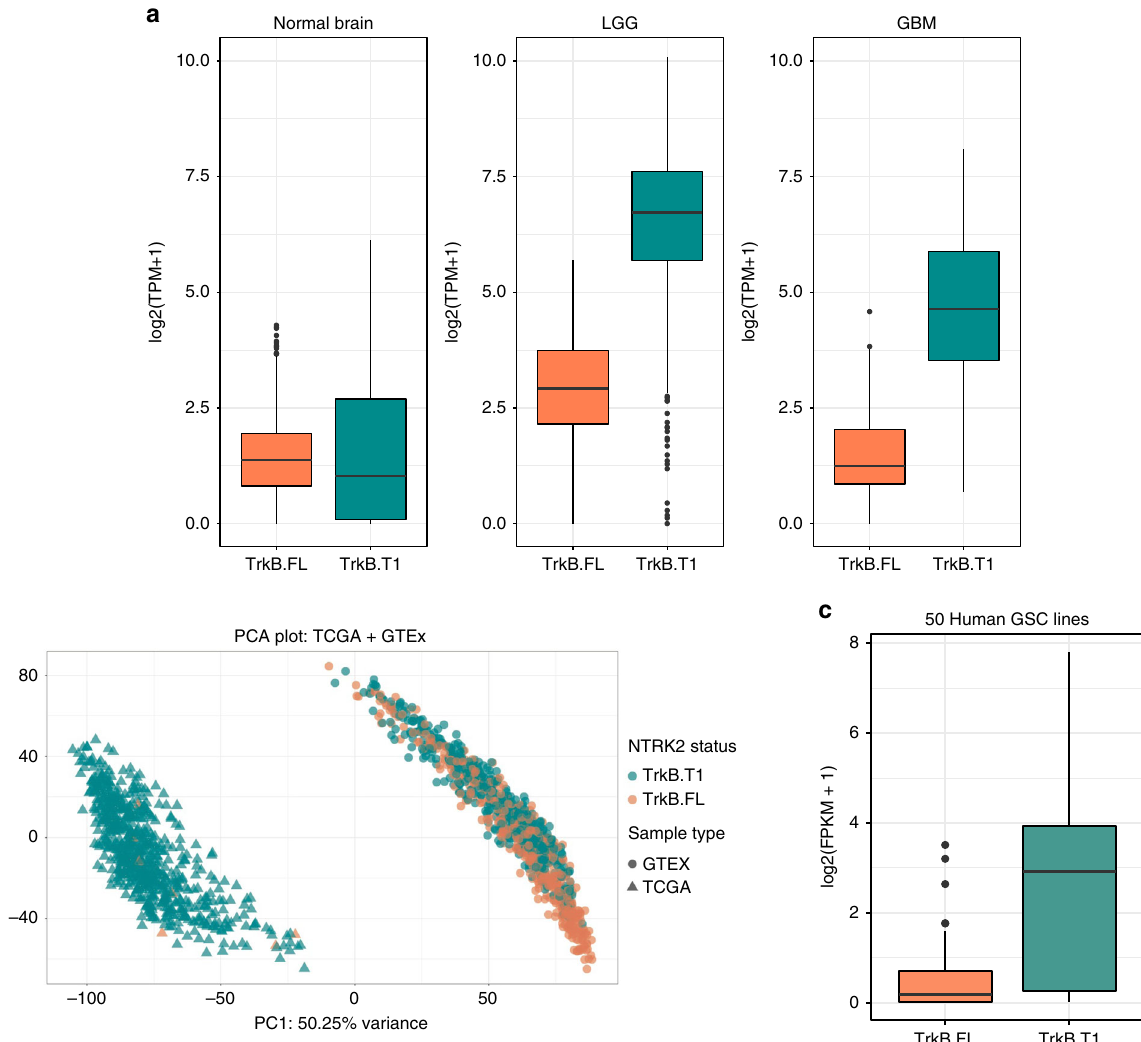
Fig. 2 NTRK2 splice variant, TrkB.T1 is the predominant TrkB isoform, in human glioma. a Boxplots for transcript expression of TrkB.FL and TrkB.T1 from brain samples from GTEx project ( n = 956) and TCGA ( n = 530) LGG and TCGA GBM ( n = 166) demonstrate a predominance of TrkB.T1 in glioma samples compared with normal brain. TrkB.T1 transcript displayed in teal, TrkB.FL transcript displayed in orange. b Principal Component analysis (PCA) plot of all brain samples from GTEx project and TCGA samples using gene expression from 20,214 genes from hg19. Samples are colored based on status of predominant NTRK2 transcript: teal for TrkB.T1 and orange for TrkB.FL. Normal brain regions are displayed as circles, brain tumors are displayed as triangles. c TrkB.T1 and TrkB.FL transcript expression shows increased expression of TrkB.T1 compared with TrkB.FL across 50 human glioblastoma stem cell (GSC) lines (6 lines: BTSC349, BTSC349, h543, h516, h561, h676; 44 lines from ref. 31 ) ( n = 50 for each isoform (TrkB.T1 and TrkB.FL); t -test, p = 1.9